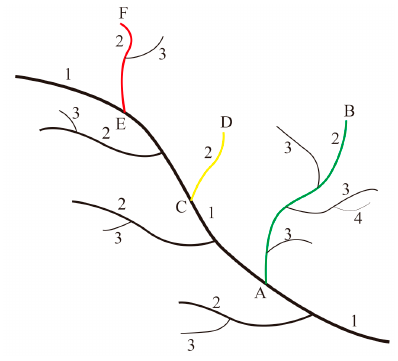
Figure 4. Inadequacies of bottom-up coding methods: three streams (AB, CD and EF) with di ff erent depths have the same code of